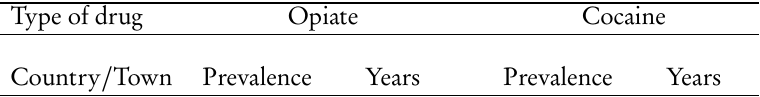
Estimated prevalence (x 100) in other European countries /